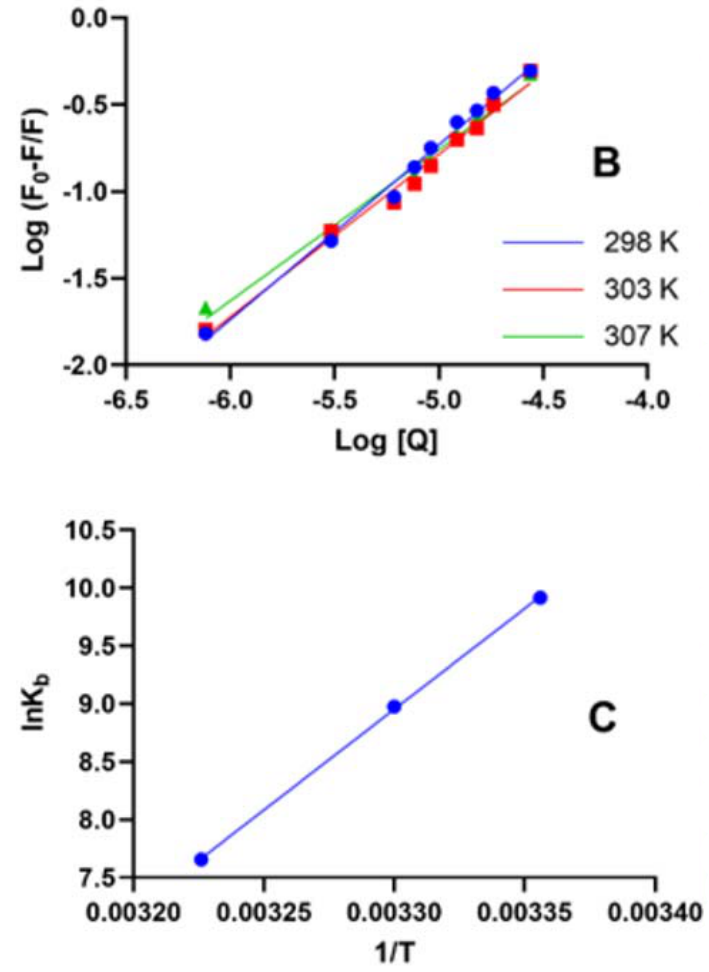
Figure 3. ( A ): Stern Volmer Plot ( B ): binding constant from double reciprocal plot ( C ): van’t Hoff plots for thermodynamic parameters for BSA (1.5 µ M)-ETB (0.00–27.5 µ M) system at 298/303/310 K. The K sv and k q were also evaluated for the ternary system for the BSA-ETB in the presence of RUT, NAR, and SIN (Table 2). The effect of the ternary system was determined by the Stern Volmer constant and biomolecular quenching constant values. These values were later compared to the binary BSA-ETB system. Table 2. Quenching constants of the binary and ternary systems at room